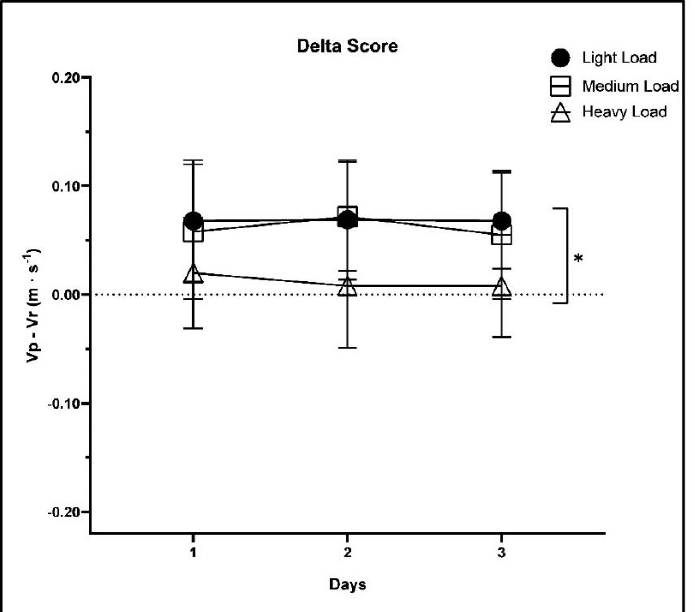
Figure 2. Mean values of the delta score (ds) for the three intensities considered in the three testing sessions. * Significant differences between light and heavy load ( p < 0.001) and between medium and heavy load ( p < 0.001).